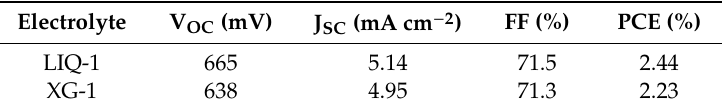
Table 1. Best photovoltaic performances for aqueous liquid and hydrogel DSSCs measured after ≈ 1100 h of